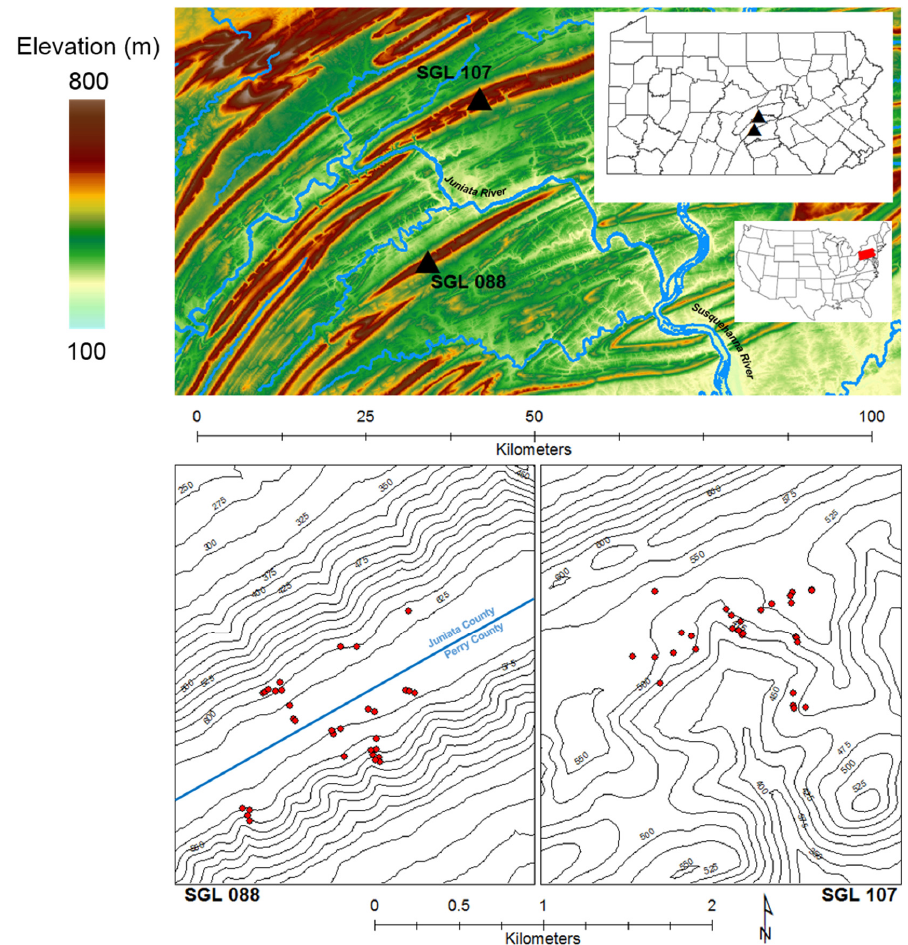
Figure 1. Top panel: Maps showing the two fire history study sites (black triangles) in relation to Pennsylvania (top inset map showing counties), the contiguous United States (bottom inset showing states, Pennsylvania in red), and the regional/local topography. Bottom panels: Topographic maps (25 m contour interval) of the two fire history sites; red dots indicate the locations of fire ‐ scarred pitch pine remnants included in the fire ‐ scar analysis. For SGL 088 topographic map, the blue line marks the Juniata/Perry County boundary, separating samples for analysis by aspect.